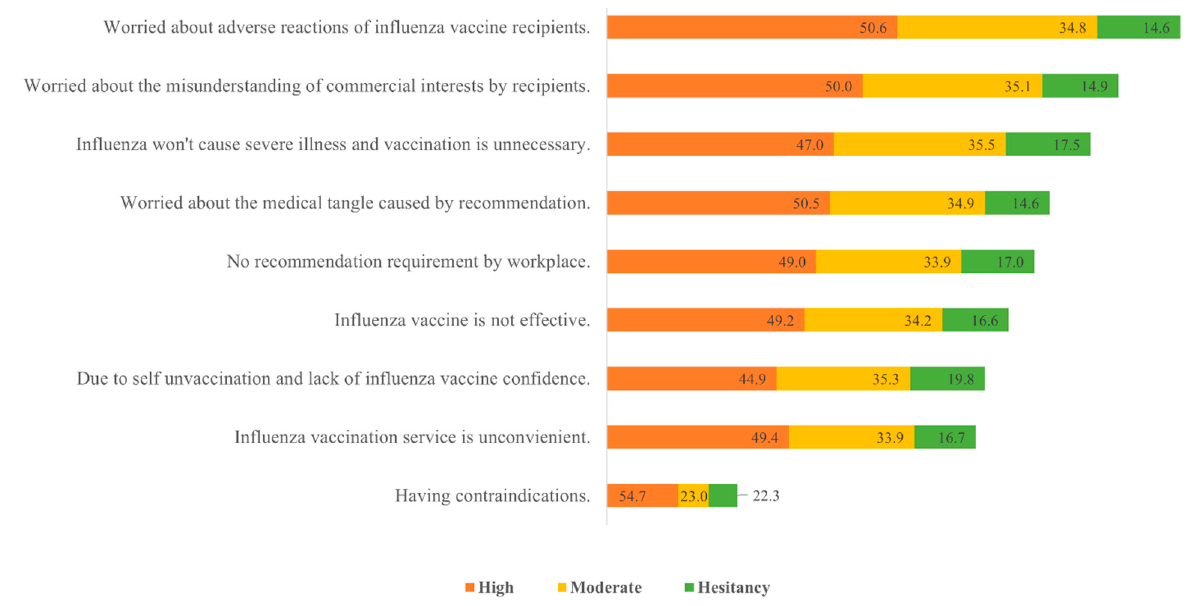
Figure 3. Barriers to influenza vaccine recommendation by healthcare workers (%). The bar chart showed the importance rank by total weight value shown by the length of the bars, and each group percentage of weight value among reasons was presented. Percentages may not total to 100 owing to round.